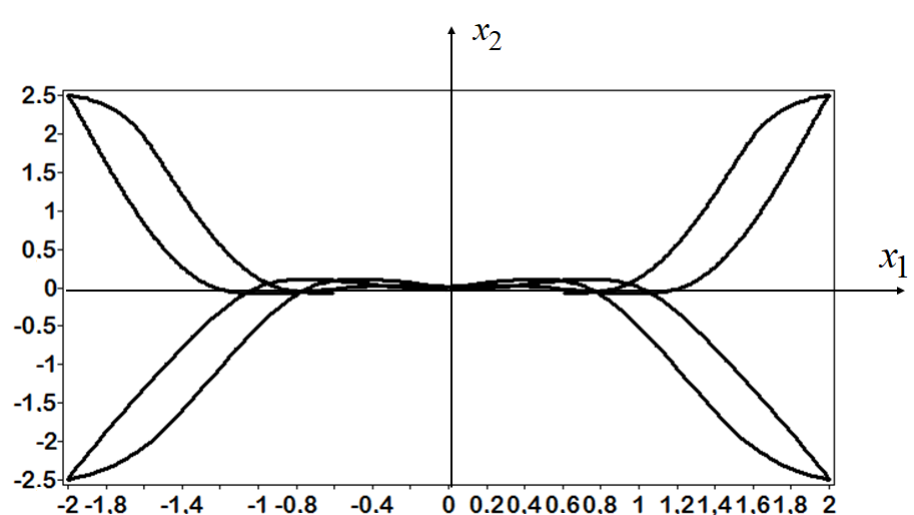
Figure 5. Trajectories of the robot with control law trained CGP.